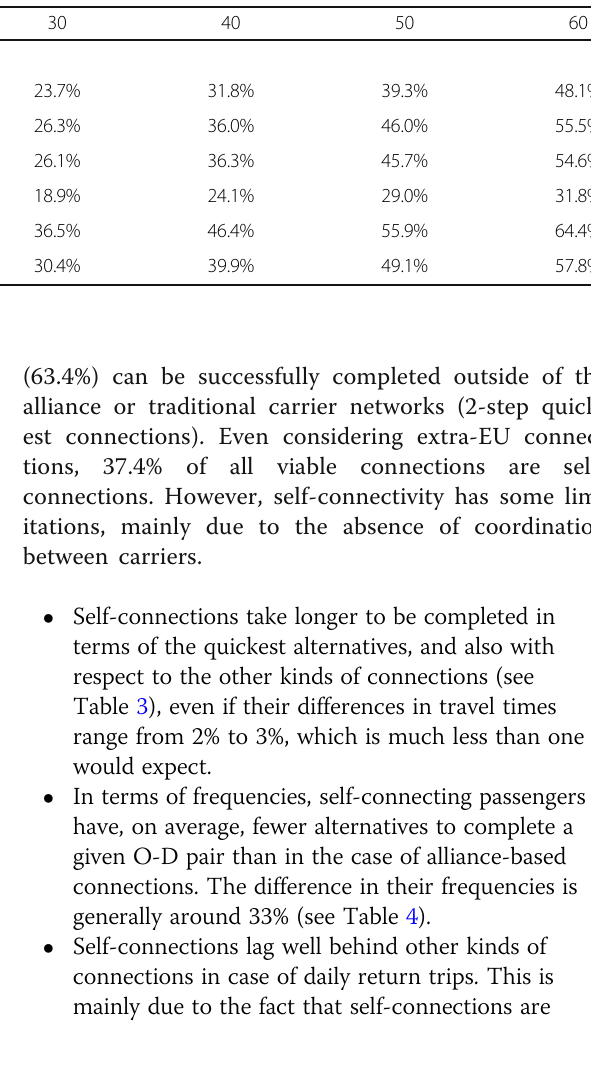
Table 7 Percentage of missed connections to extra-EU destinations related to delayed arrivals at intermediate airports Extra-EU